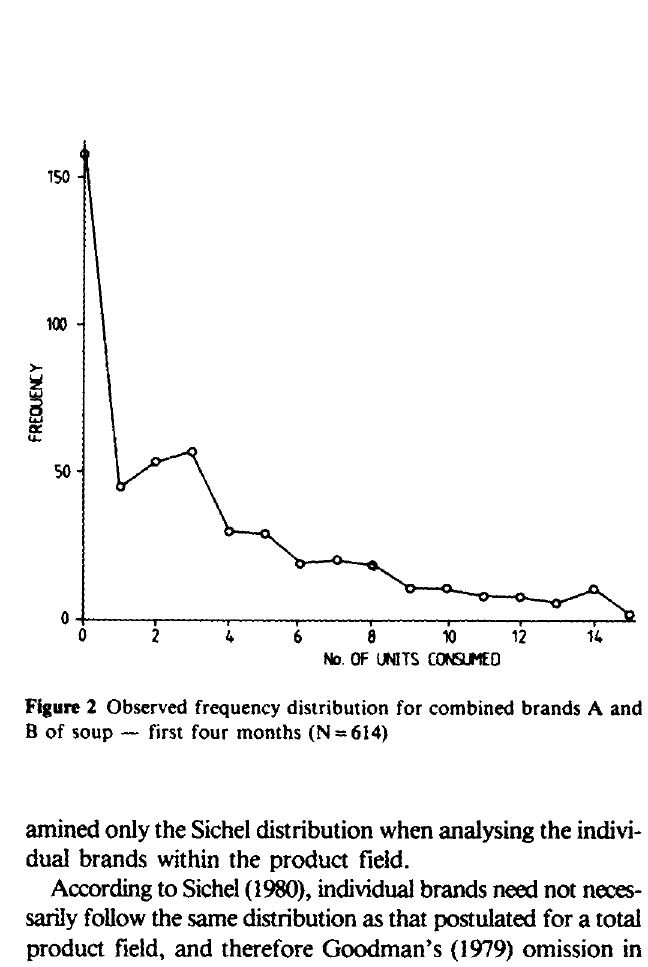
amined only the Sichel distribution when analysing the indivi dual brands within the product